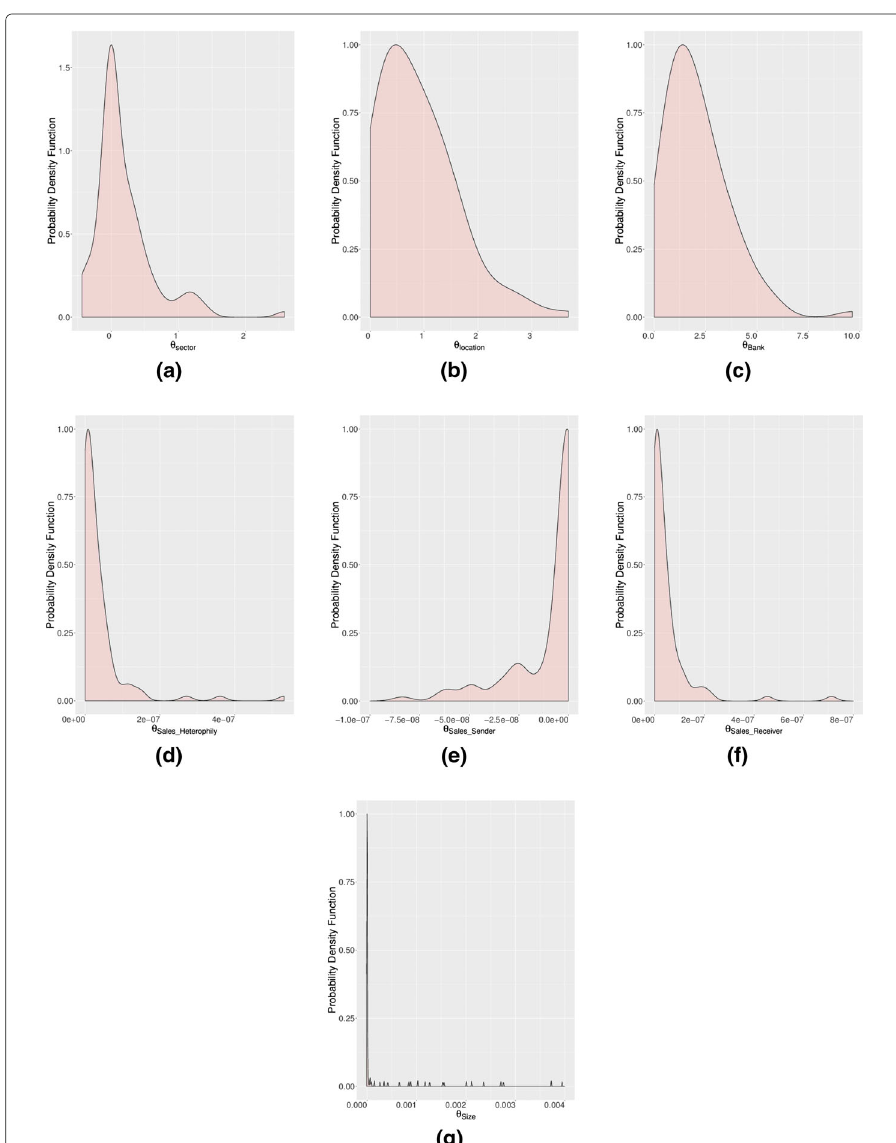
Fig. 3 The probability density functions of the estimated parameters θ for the exogenous attributes. Estimates were obtained for the 100 considered communities at the second level of the hierarchical structure of the Japanese production network. These graphs are used to illustrate the distribution of the results, thereby highlighting the negative, positive and nonsignificant values of (cid:2) . However, these graphs are not used to compare the values of (cid:2) between communities since they have different sizes